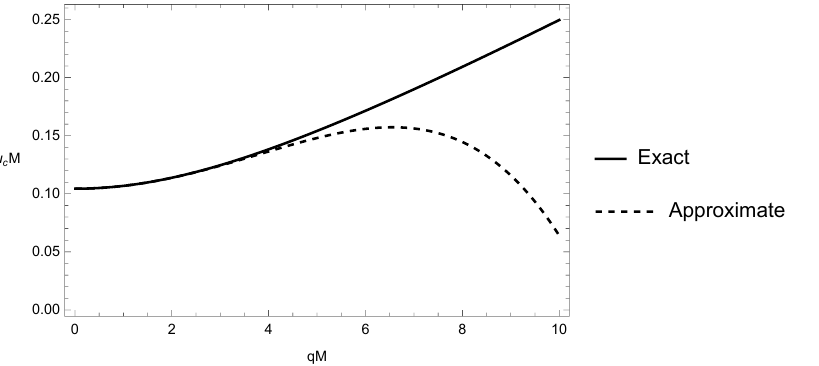
Figure 7 . The behaviour of the critical scalar field mass µ c M as a function of qM , with Q/M = 0 . 1 and Λ M 2 = 0 . 01 . The continuous line corresponds to the exact results, and the dashed line corresponds to the approximate results given by (3.18).